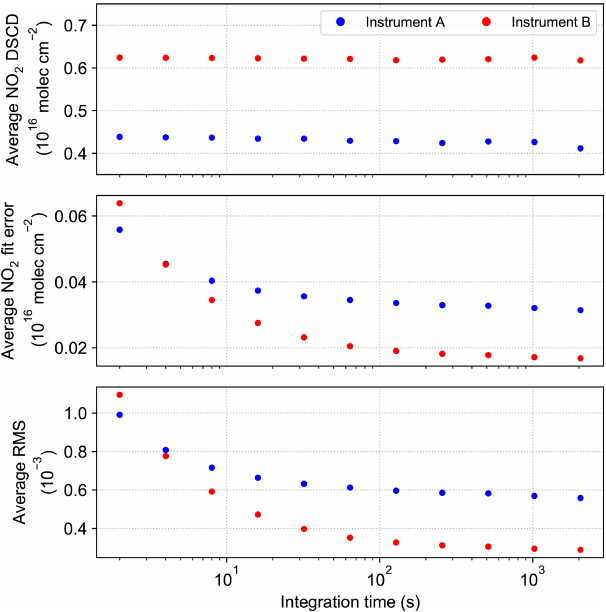
Figure 3. Average NO 2 DSCD, fit error and RMS for both mea- surement sites (Instrument A: west side, upwind; Instrument B: east side, downwind) for different integration